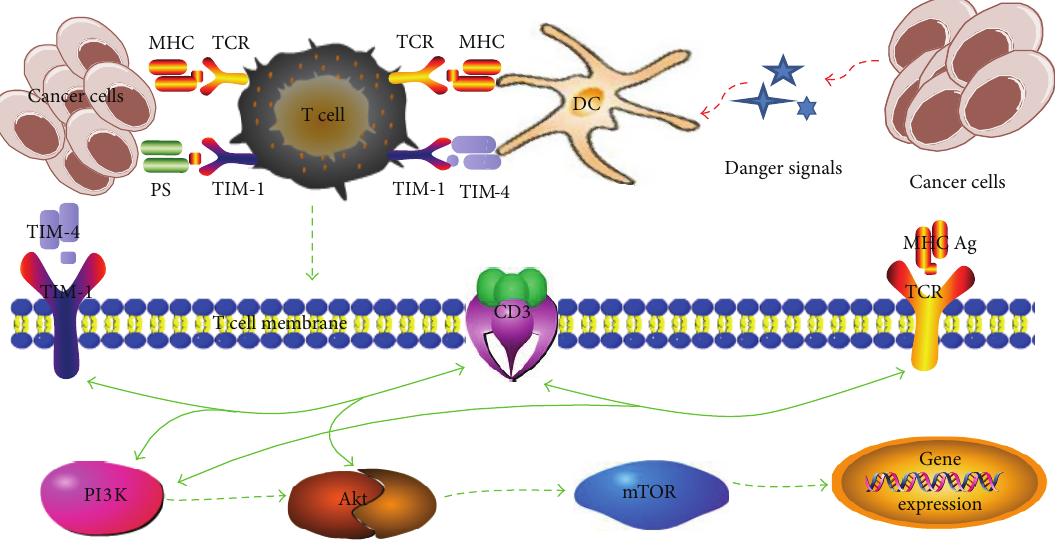
Figure 1: Tumor cells release signals, which are received by dendritic cells (DCs). Tumor antigens are processed to MHC antigens and then presented to the T cell receptor (TCR) for activation. TIM-4 (or phosphatidylserine) on DCs binds to TIM-1 on T cells to form the CD3- TCR complex, which participates in TCR-mediated T cell activation and initiates the intracellular PI3K signal pathway. PI3K signal pathway consists of the interaction between TIM-1 and ligands, tyrosine phosphorylation of the intracellular region of TIM-1, the recruitment of PI3K, the activation of Akt by PI3K, and the activation of mTOR by Akt. Activated mTOR can regulate the biological functions of T